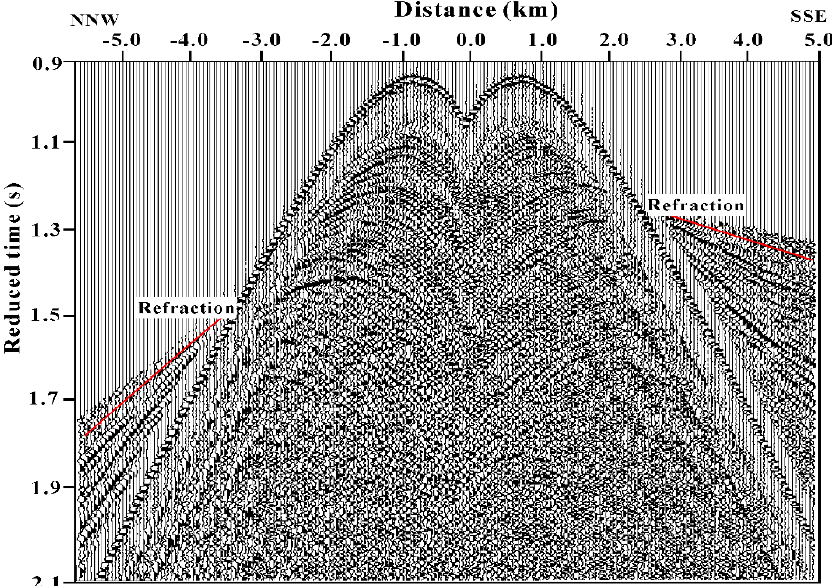
Figure 3. Hydrophone component of OBS 7 showing travel time picks (red lines) of refraction. The signal above the refraction is noise. The horizontal axis is the distance between projected OBS position and shot position. The time is reduced with a velocity of 3.2 km/s.